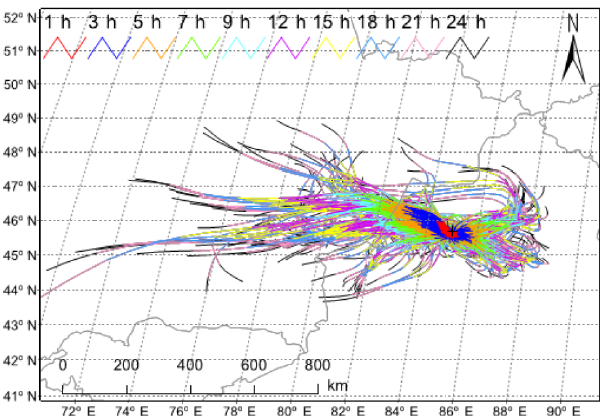
Figure C1. The region covered by the first 24h backward trajecto-